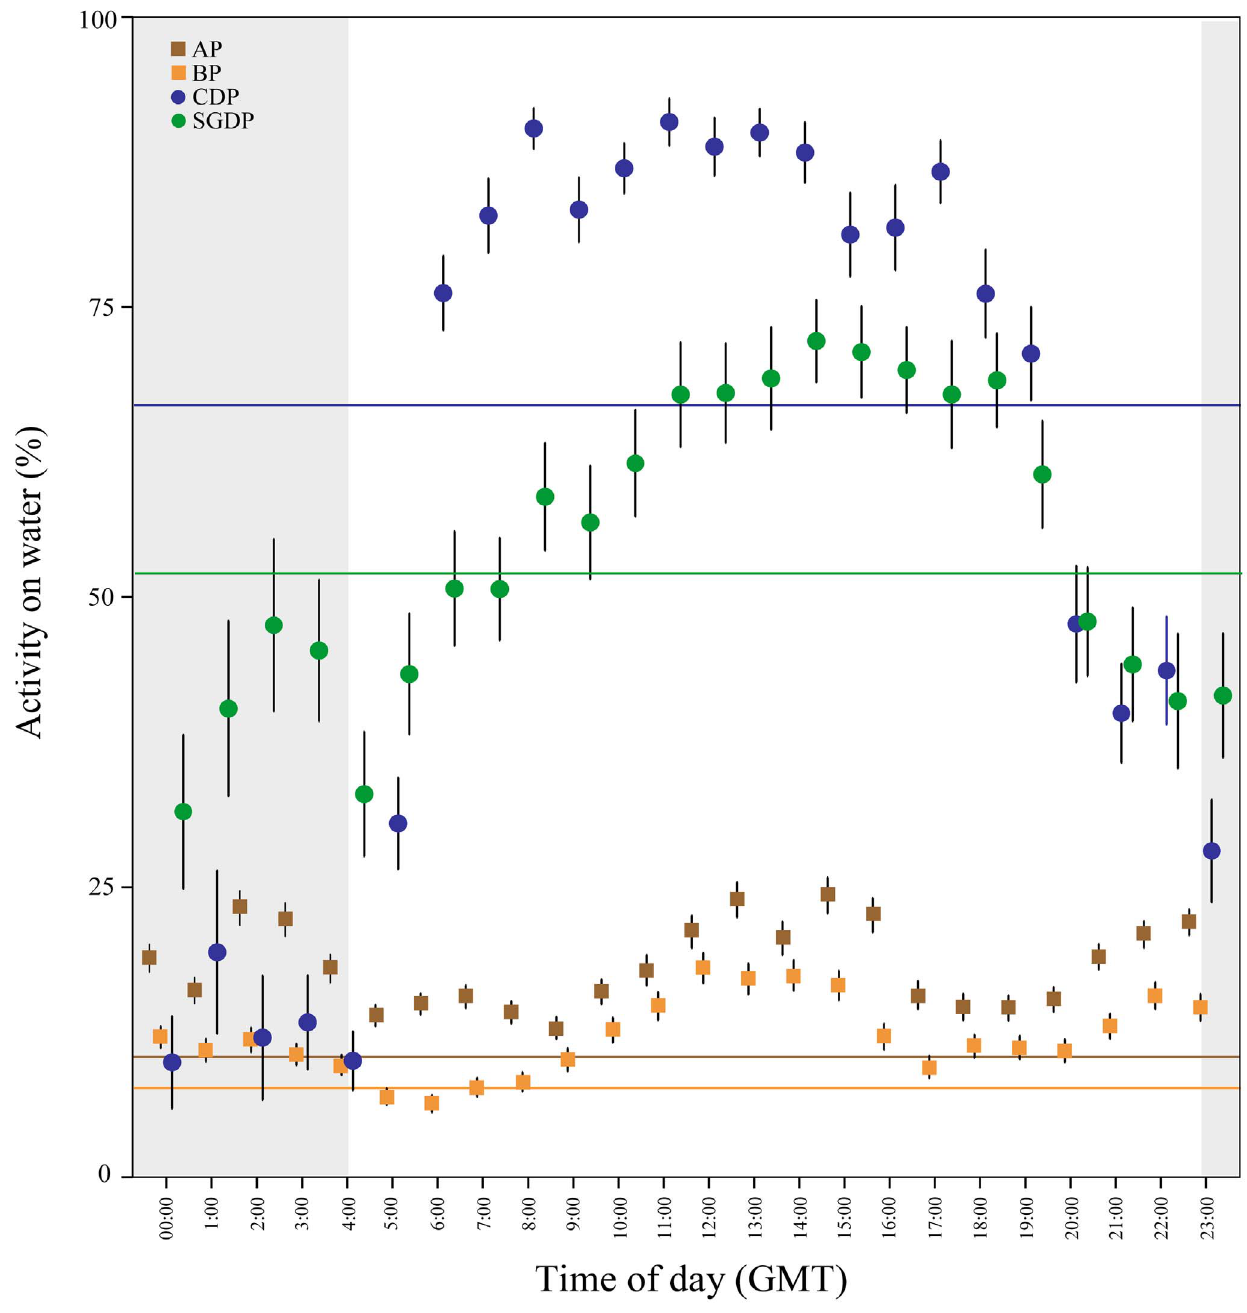
Figure 6. At-sea activity patterns. Mean daily percentage of time spent on water 6 SE of 12 Antarctic prions (AP), 12 blue petrels (BP), 9 common diving petrels (CDP), and 8 South Georgian diving petrels (SGDP) tracked using immersion loggers during incubation at Bird Island, South Georgia in summer 2010/11. Shaded areas indicate darkness. The mean value of waveform for each species is indicated with a horizontal line (different colour for each